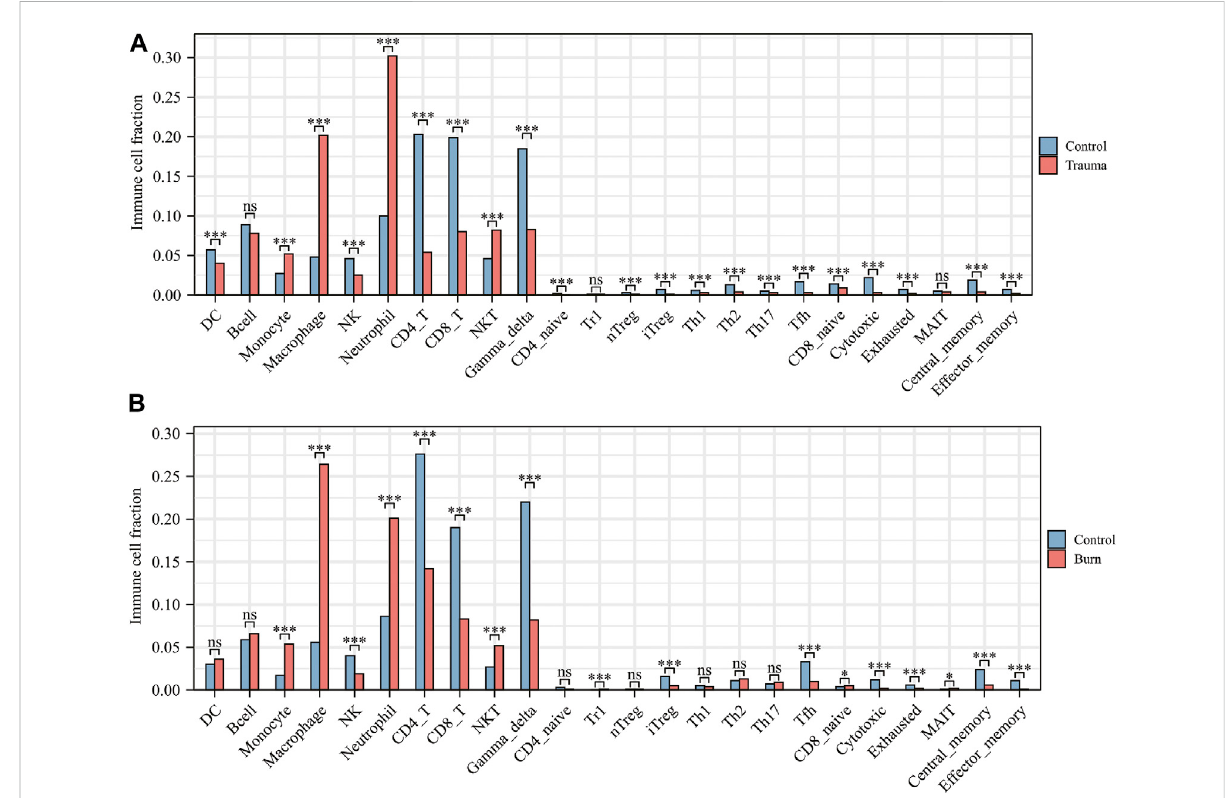
FIGURE 6 (A) Comparison of immune cell fractions between blunt trauma patients and healthy controls. (B) Comparison of immune cell fractions between burns patients and healthy